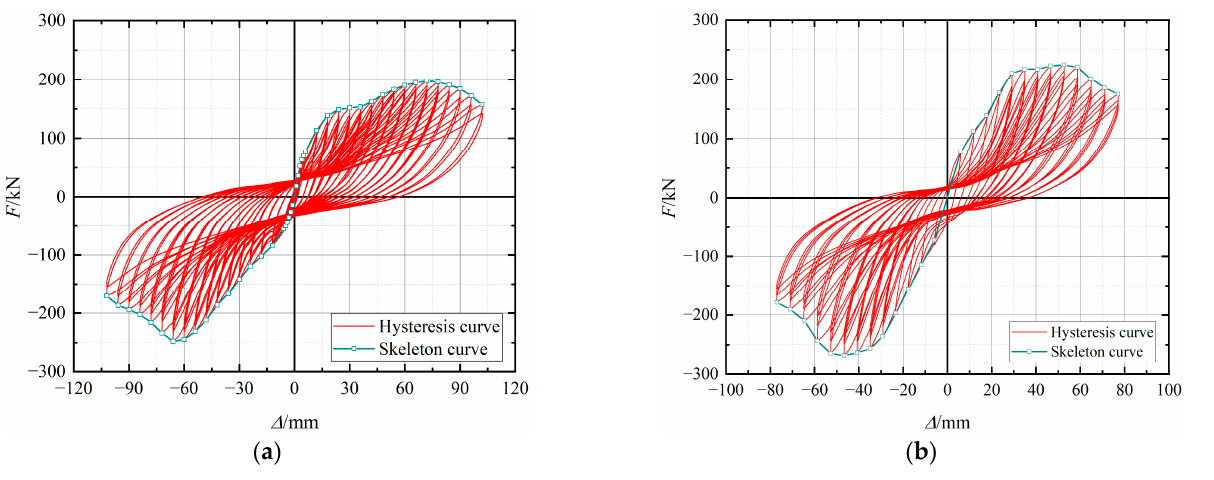
Figure 10. The hysteresis curves: ( a ) WP-1; ( b ) WP-2.